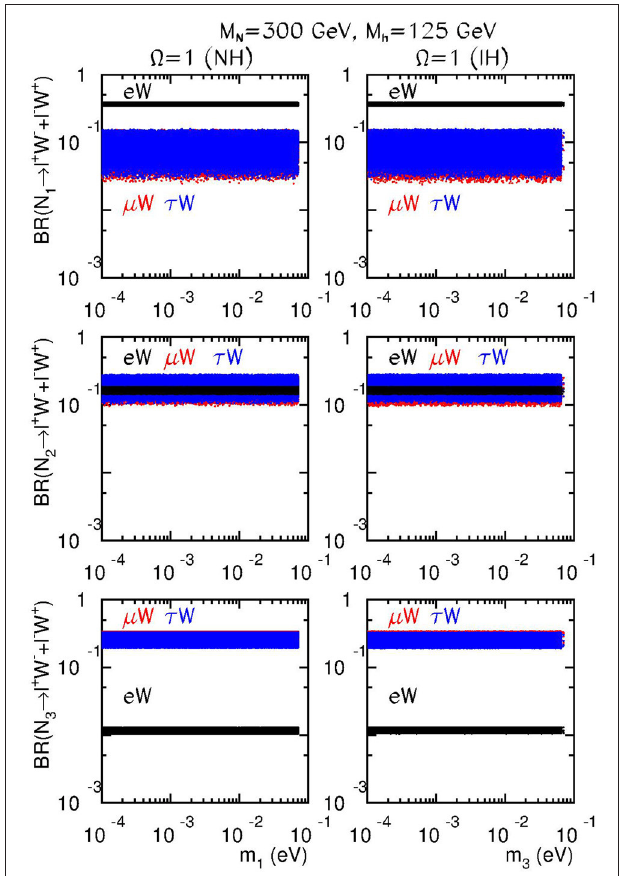
ℓ + W − ℓ − W + vs. the → + I with M i 300 GeV and = =